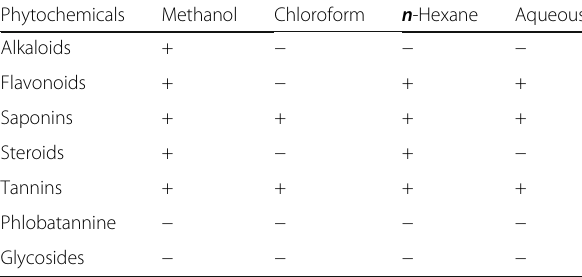
Table 2 Phytochemical analysis of fresh papaya flowers Phytochemicals